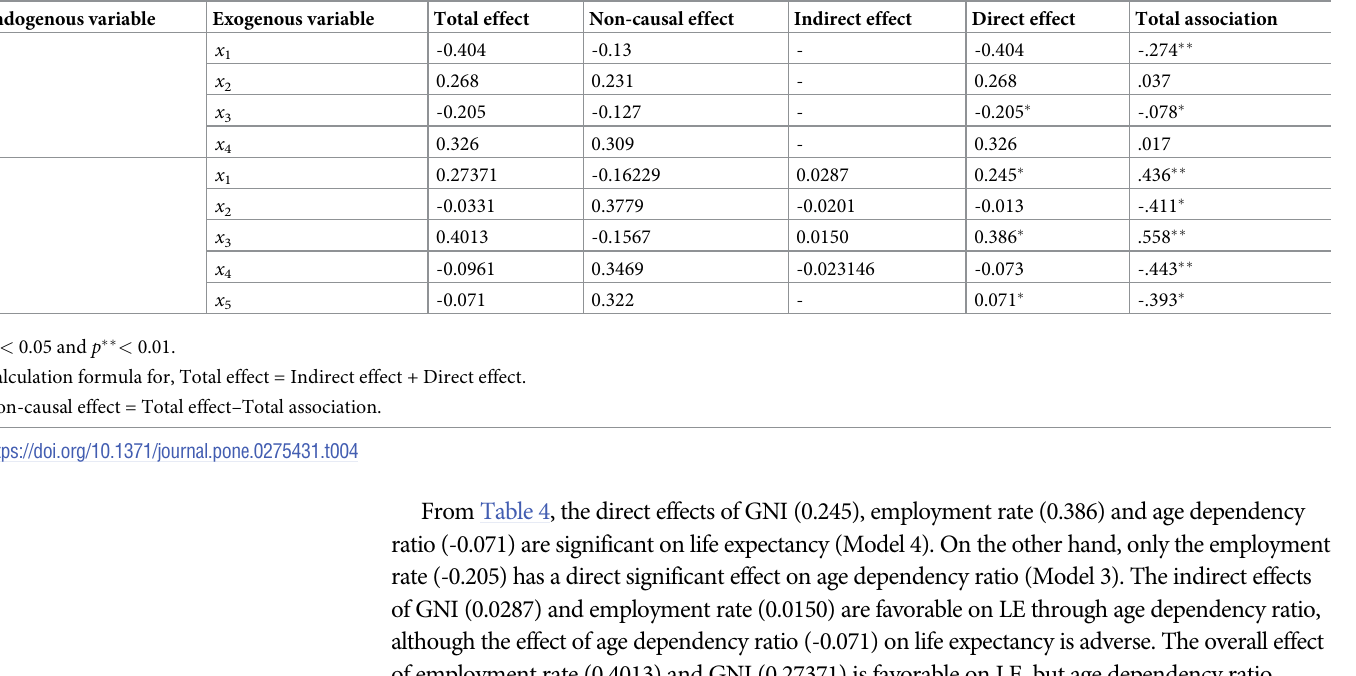
From Table 4, the direct effects of GNI (0.245), employment rate (0.386) and age dependency ratio (-0.071) are significant on life expectancy (Model 4). On the other hand, only the employment rate (-0.205) has a direct significant effect on age dependency ratio (Model 3). The indirect effects of GNI (0.0287) and employment rate (0.0150) are favorable on LE through age dependency ratio, although the effect of age dependency ratio (-0.071) on life expectancy is adverse. The overall effect